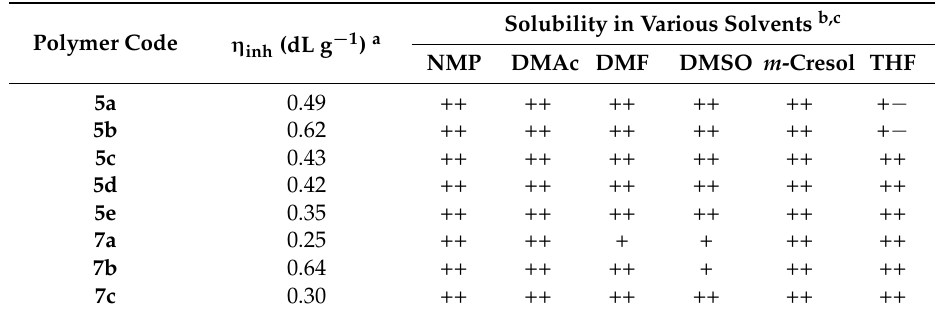
Table 1. Inherent viscosity and organosolubility of the polymers. Polymer code